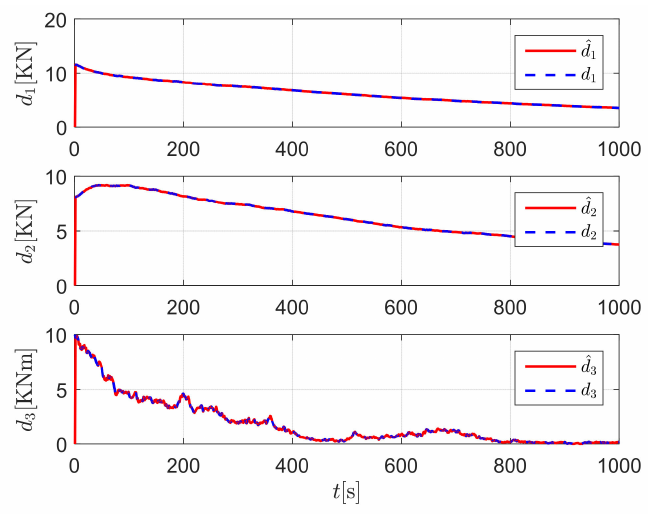
Figure 11. The time response curves of ship’s velocities in Case 2.